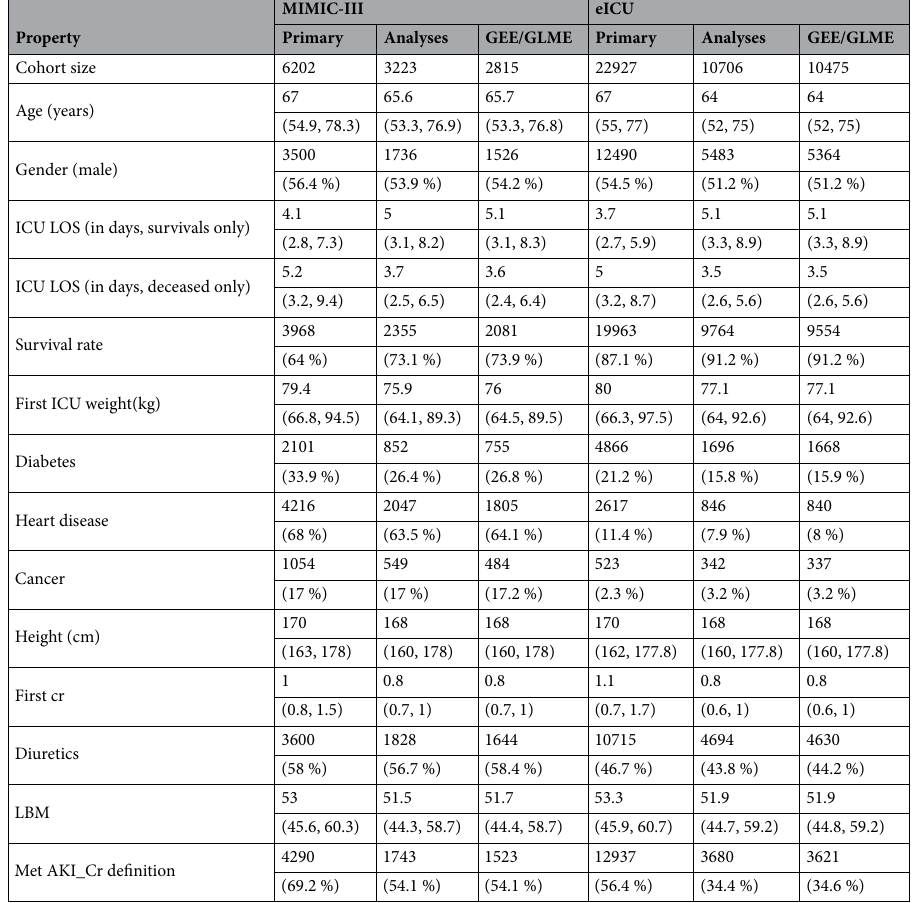
Table 1. Study population characteristics. Representation of binary and continuous properties of primary, analyses, and GEE/GLME cohorts. Properties include LOS length of stay, LBM lean body mass, AKI Cr acute kidney injury based on creatinine. Binary properties are indicated with percentages of positive cases, and continuous properties are indicated with median and interquartile